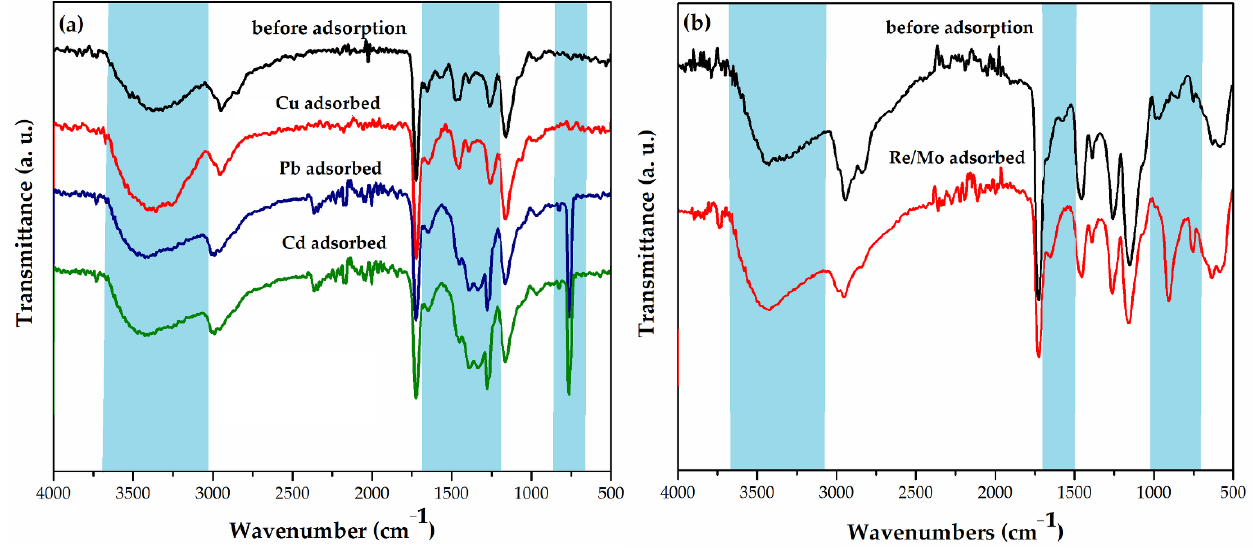
Figure 2. ( a ) FTIR-ATR spectra of PGME-deta before adsorption (black) and after adsorption: PGME-10/12-deta/Cu (red), PGME-10/12-deta/Pb (blue), and PGME-10/12-deta/Cd (green) [118], ( b ) FTIR-ATR spectra of mPGME-deta before adsorption (black) and after adsorption of Re(VII)/Mo(VI) (red) [130].